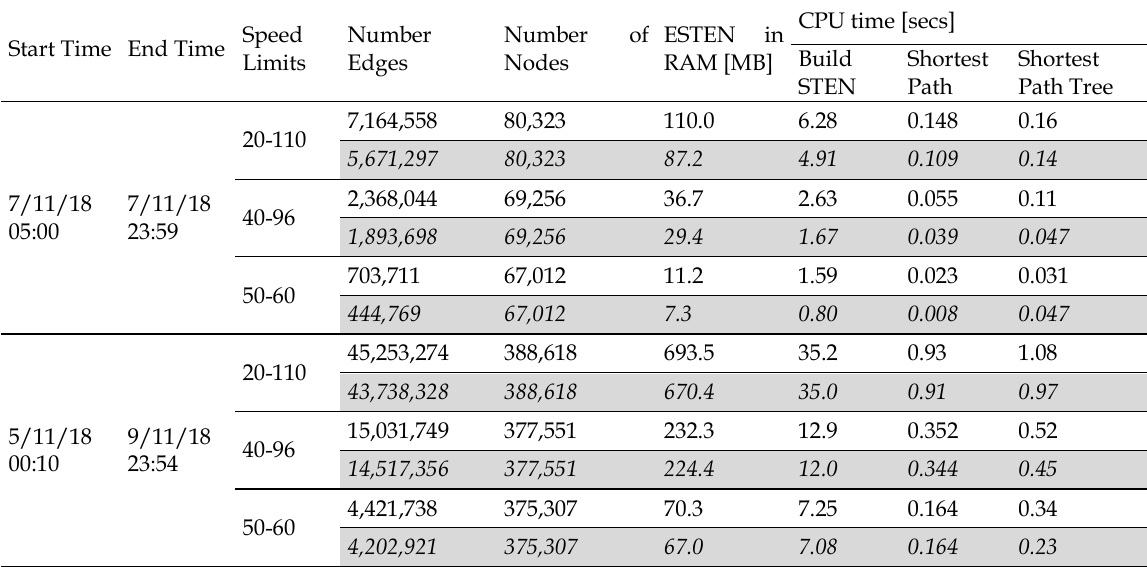
Table 8. Computation times for different size ESTEN, all shortest paths using Dijkstra method. Shaded cells in italics show edge reduction by earliest node arrival time Speed Start Time End Time Limits